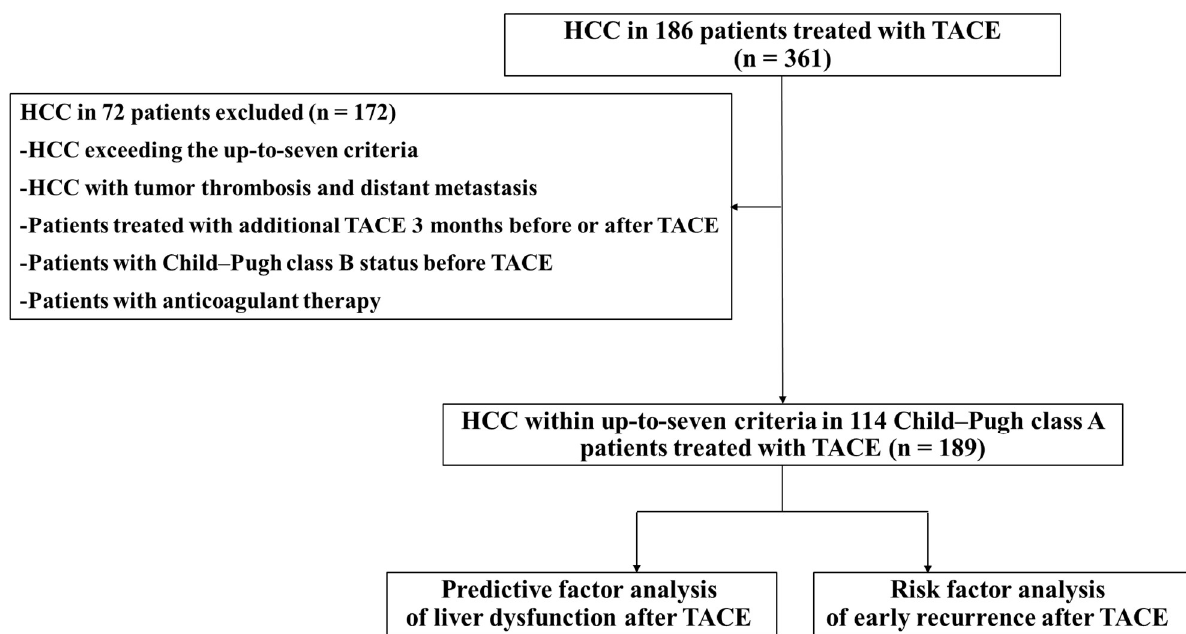
Figure 1. Study design. A total of 361 hepatocellular carcinoma (HCC) tumors in 186 patients were treated with transcatheter arterial chemoembolization (TACE). We excluded patients with HCC exceeding the up-to-seven criteria at the time of each TACE, HCC with tumor thrombosis and distant metastasis at the time of each TACE, additional TACE treatment 3 months before or after undergoing each TACE, Child–Pugh class B status before undergoing each TACE, and patients with anticoagulant therapy. We performed predictive factor analysis of liver dysfunction and risk factor analysis of early recurrence after each TACE in 189 HCC tumors from 114 patients with Child–Pugh class A. HCC, hepatocellular carcinoma; TACE, transcatheter arterial chemoembolization.